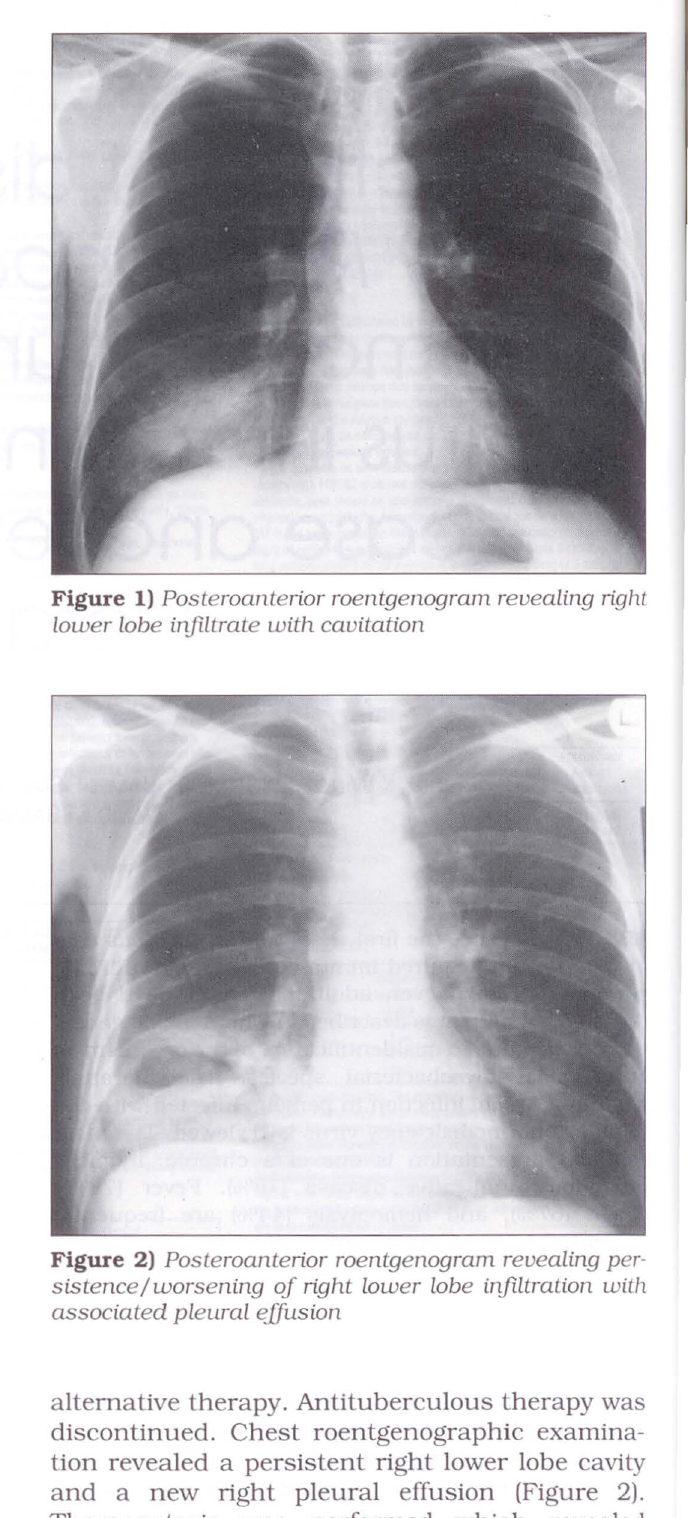
Figure 2) Posteroanterior roentgenogram revealing per sistence/worsening of right lower lobe infiltration